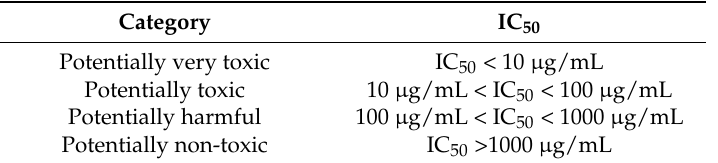
Table 1. Classification of cytotoxicity for natural ingredients [28].